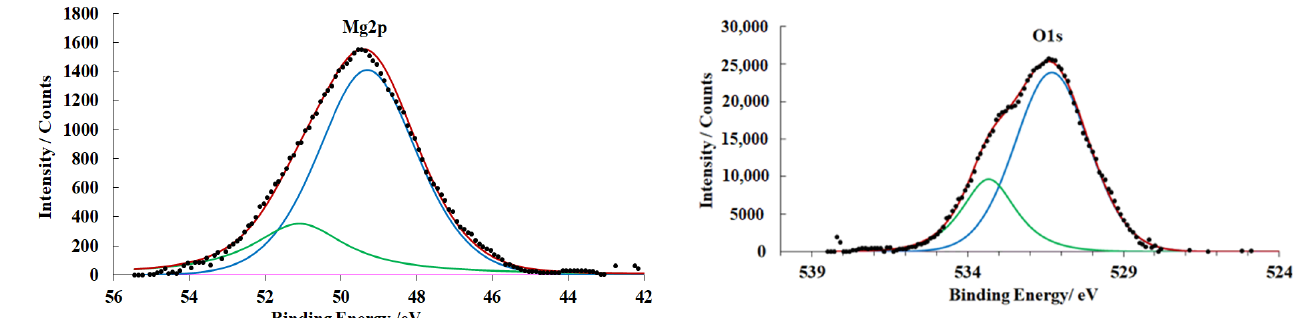
Figure 6. XPS spectra of magnesium alloy samples (preparation mode B ).